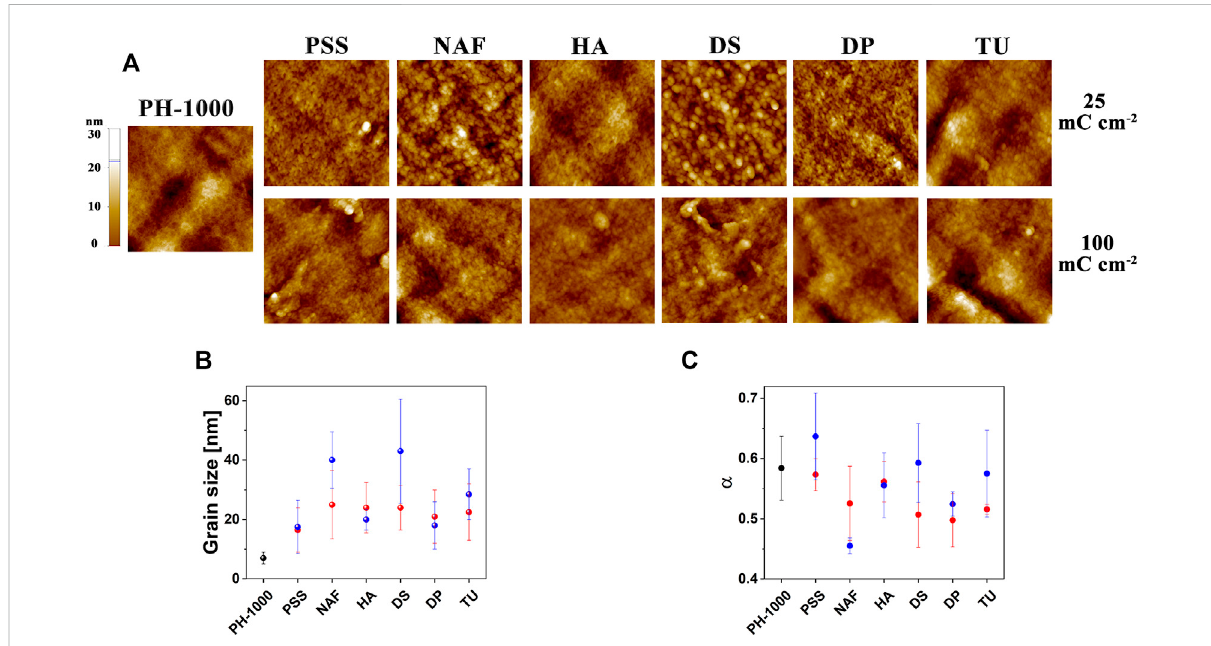
FIGURE 3 Results of AFM analysis. (A) Topography images (scan size is 1 × 1 μ m 2 ) of the PH-1000 layer and of the electrodeposited PEDOT/X thin fi lms deposited at